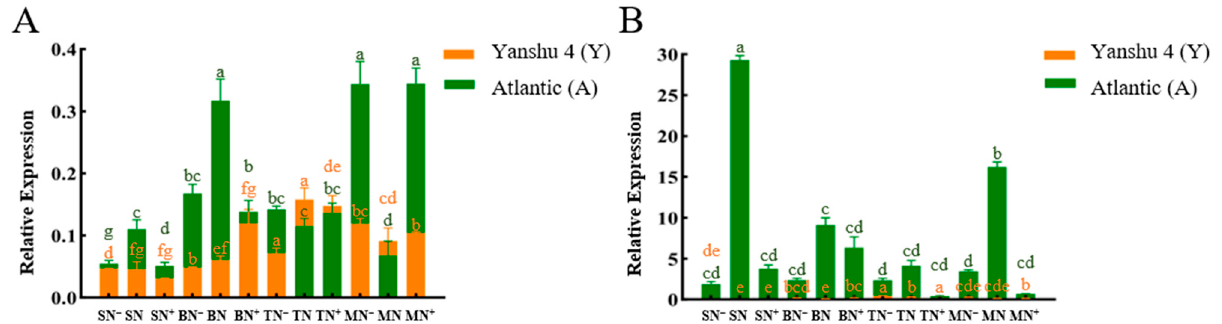
Figure 7. Relative expression of glutamine synthase gene StGS2 in two genotypes of potato under different N supply levels. ( A ) Leaf (L); ( B ) Root (R). S, B, T, and M represent seedling stage, budding stage, tuber expansion stage, and mature stage, respectively. N − , N, N + are different N supply levels, representing low N, normal N, and excess N, respectively. Different letters indicate the difference of relative gene expression in different periods under different N application levels ( p < 0.05).